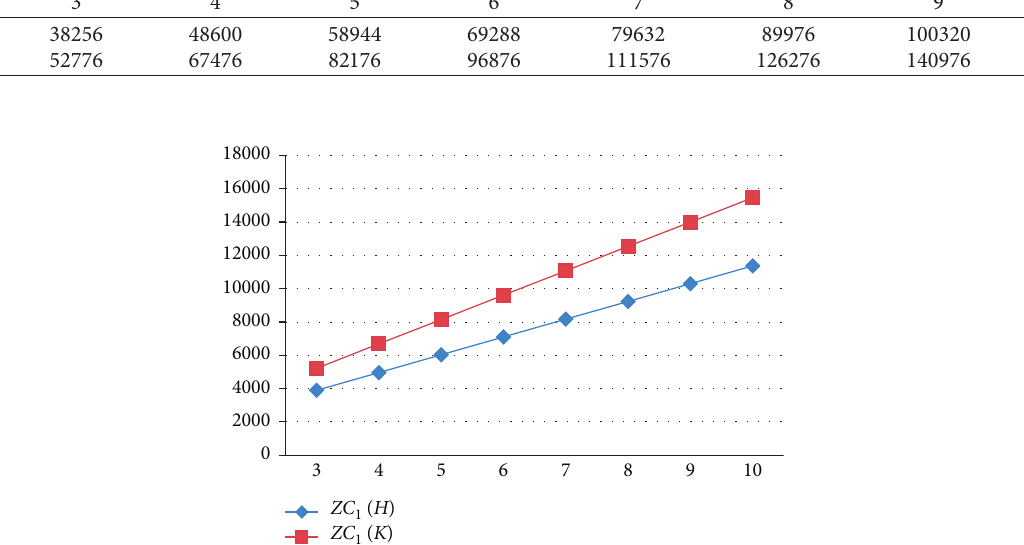
Table 14: Numerical values of ZC ∗